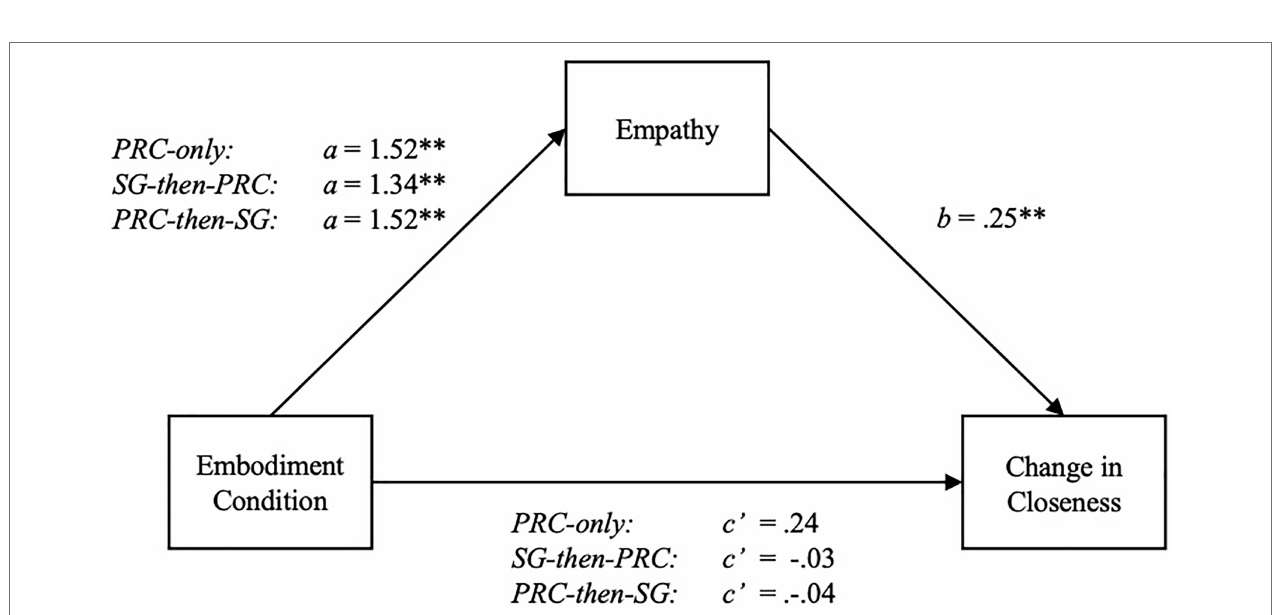
FIGURE 4 | Statistical model of empathy mediating the relative effects of embodiment condition on differences in feeling thermometer scores (attitudes). Coefficients are based on z-scored standardized values for empathy and feeling thermometer change scores. * p < 0.05; ** p < 0.01.